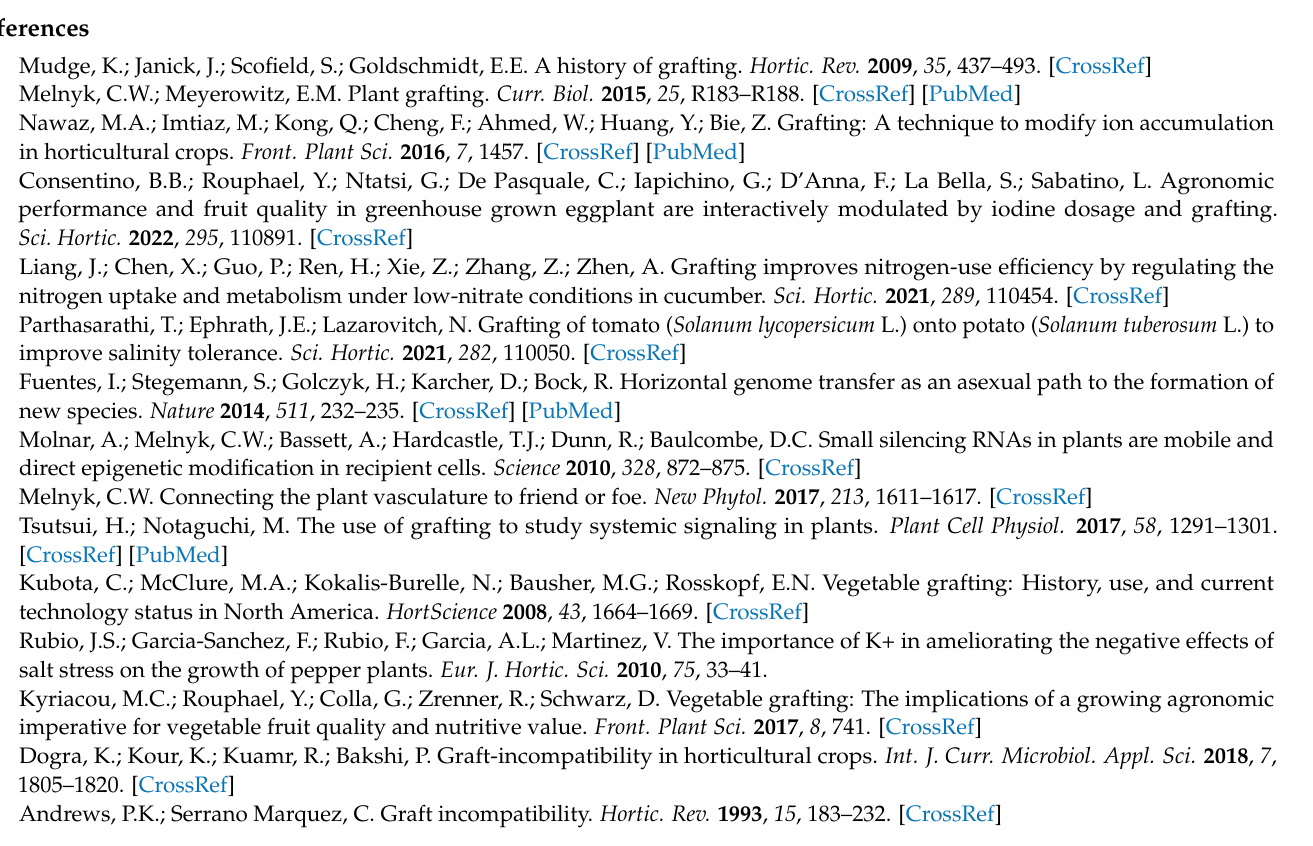
Table S1: GH9 members of Pepper, Tomato and Tobacco; Table S2: Cis-acting element of GH9 members; Table S3: List of cis-elements in the promoter of solanaceous GH9B3 gene; Table S4: Co-expressed transcription factors; Table S5: Duplication events of NbGH9 in tobacco; Table S6: qRT-PCR